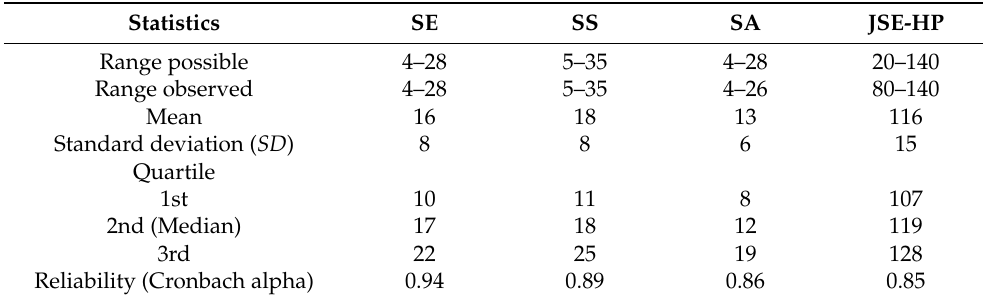
Table 2. Descriptive analysis and reliability coefficients ( n =